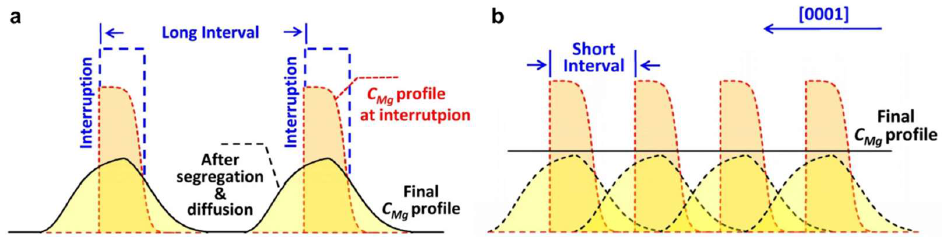
Figure 9. Schematic diagram of the Mg incorporation behavior in the AlGaN grown by the MSE technique. ( a ) When the interruption interval is long, only some peaks distribute locally at the interruptions after Mg segregation and diffusion. ( b ) After optimizing the interruption interval, a high and uniform Mg distribution over the entire AlGaN epilayer was achieved [100].